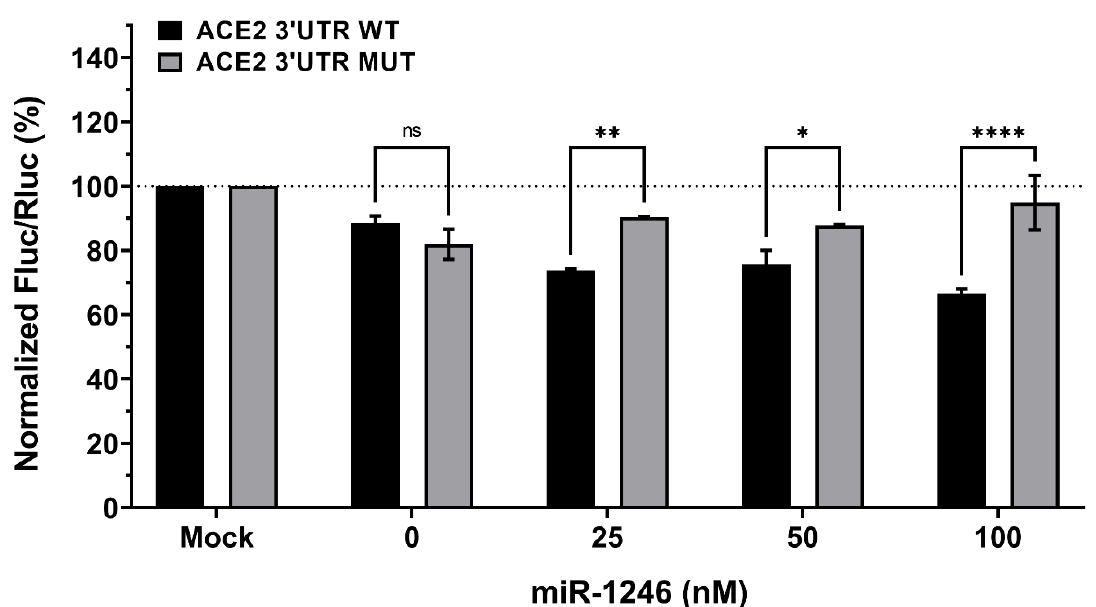
Figure 7. Modulation of human ACE2 mRNA by hsa-miR-1246. Calu3 cells were co-transfected with Homo sapiens (hsa) human miR-1246 mimic (0, 25, 50 and 100 nM) and a psiCHECK2 reporter construct (50 ng; see Supplementary File S4), in which the Rluc reporter gene was coupled with the wild-type (WT) or mutated (MUT) human ACE2 3′ untranslated region (UTR). An unrelated, negative miRNA control (Mock) was used for normalization in addition to the internal normalizer Fluc. The concentration “0 nM” corresponds to the transfection-reagent-only control. Statistical analysis: Data were calculated from three biological replicates and expressed as means ± SD. The two-way analysis of variance (ANOVA) and Šídák’s multiple comparisons test were used. Statistically significant differences (fold change WT vs. MUT) are indicated as follows: * p < 0.05; ** p < 0.01; **** p < 0.0001; ns, nonsignificant.